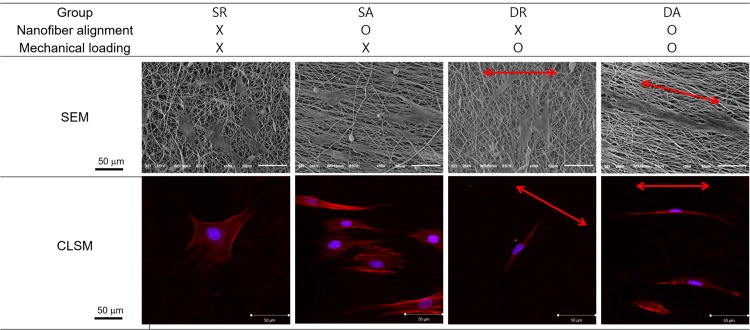
Effect of the cyclic uniaxial stretch on the orientation of PDL cells.Examination of cell shaping on the differently-aligned nanofibers with or without applying dynamic mechanical load. F-actins visualized with rhodamine-phalloidin (red) and nuclei stained with DAPI (cyan) for fluorescent images. Red arrows indicate stretch direction.